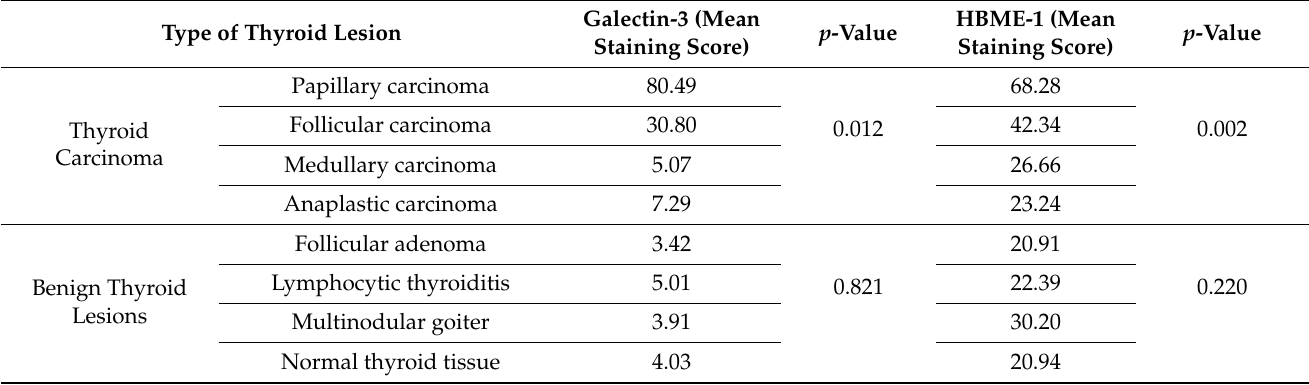
Table 3. Mean staining scores of Gal-3 and HBME-1 across subtypes of thyroid carcinoma and subtypes of benign thyroid lesions.